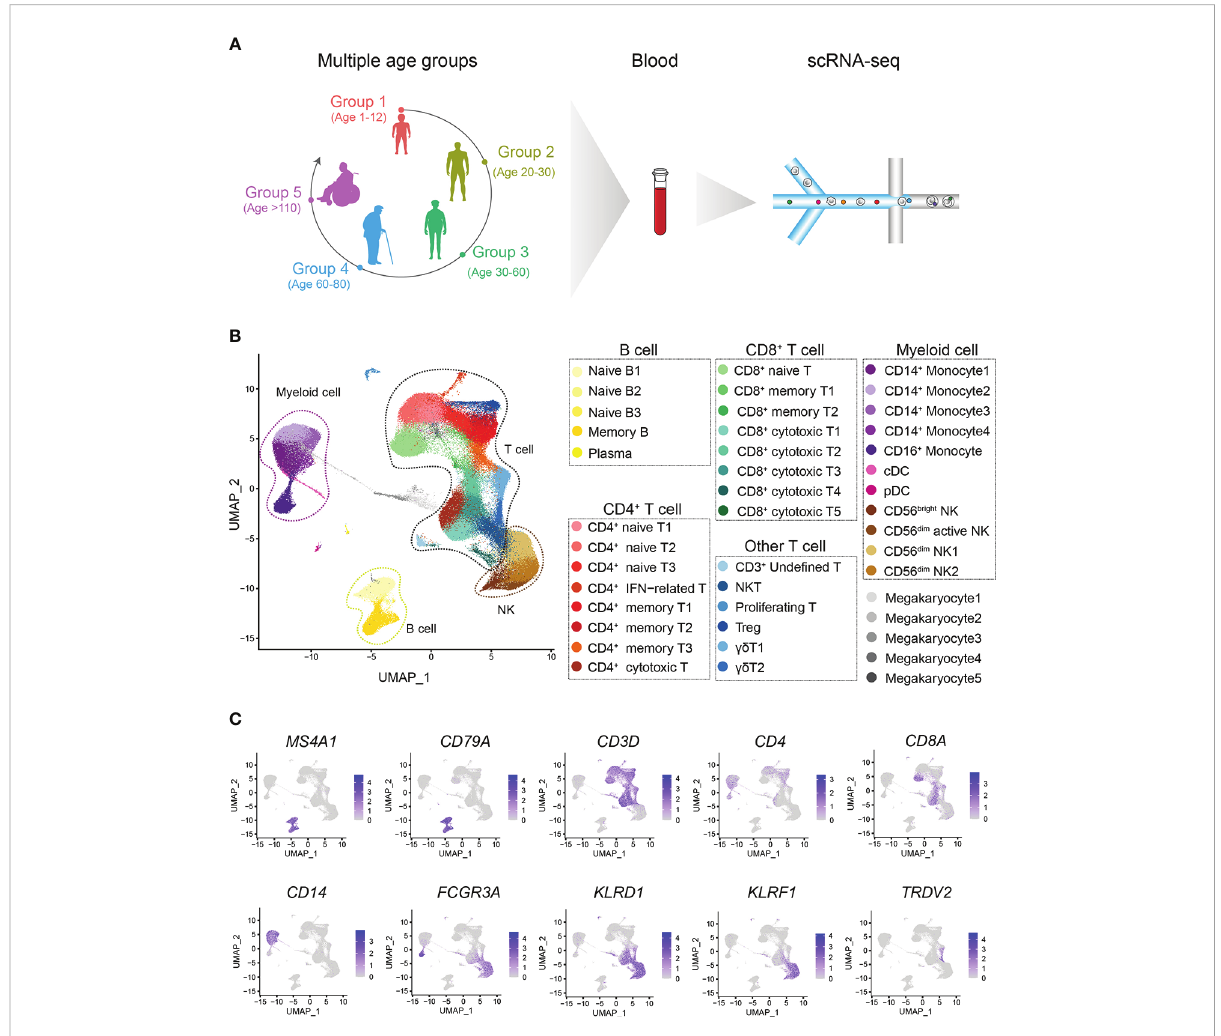
FIGURE 1 Single-cell transcriptome pro fi ling of the PBMCs of healthy children and multiple other age groups. (A) Schematic representation of the cell pro fi le of blood immune cells in multiple age groups. (B) Two-dimensional UMAP visualization of PBMCs for multiple age groups. Different colors represent 43 clusters (cell types). (C) Expression of marker genes for 7 main cell types; cell positions are from the UMAP plot in (B)